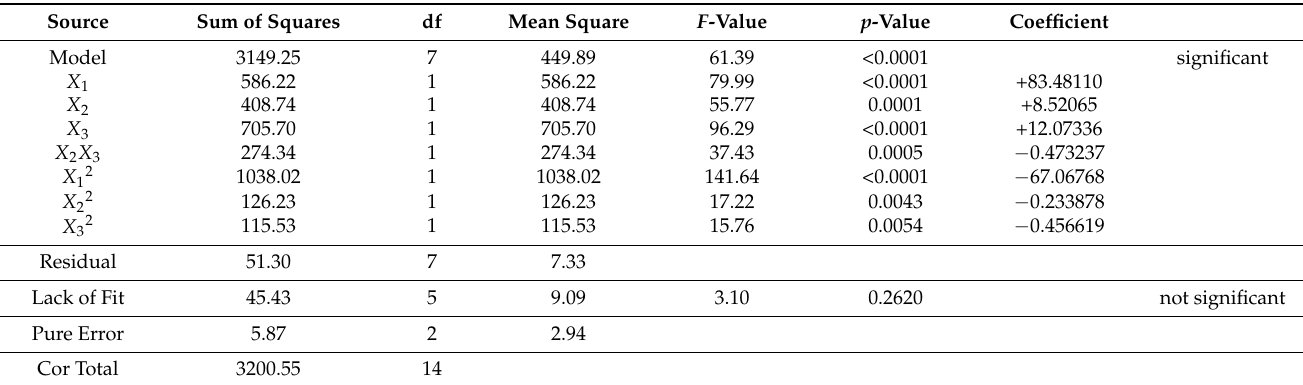
Table 2. ANOVA results for response: the DPPH